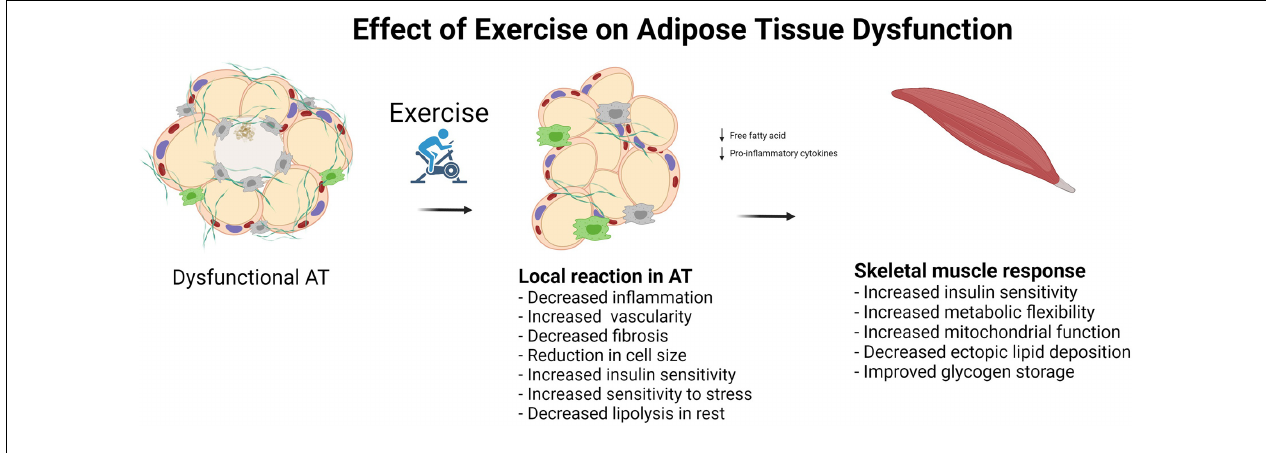
FIGURE 3 | Effect of exercise on adipose tissue